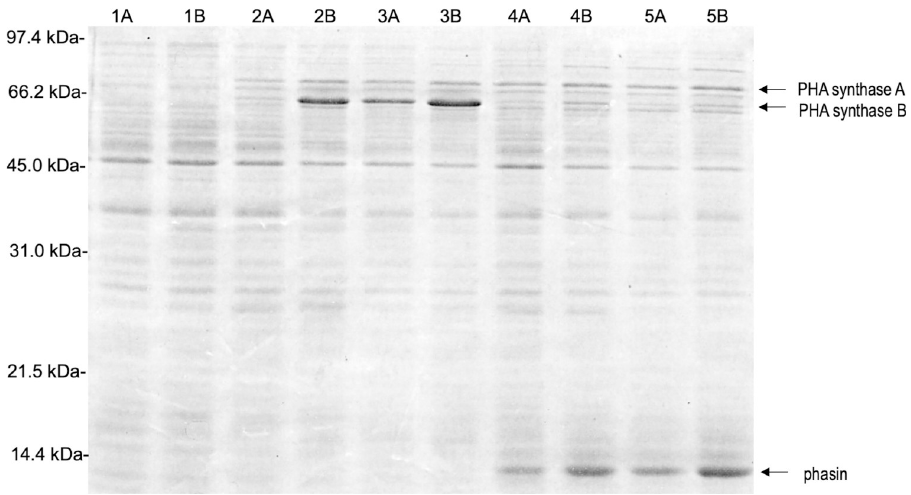
Fig 3. Comparison of chemical and thermal induction in E . coli XL1-Blue using SDS-PAGE analysis. Sample 1: (pDKE6) 30˚C, 2: (pDKF2) 41˚C, 3: (pDKF2) 41˚C + IPTG, 4: (pDKE6) 41˚C, and 5: (pDKE6) 41˚C + IPTG. A = 1.5 hours post induction, B = 3.0 hours post induction. The sample volume was adjusted so that each lane contained the same amount of protein. The arrows indicate the probable location of PHA synthase (67.306 kDa or 62.675 kDa depending upon the location of the translational start) and the phasin (13.153 kDa predicted size).